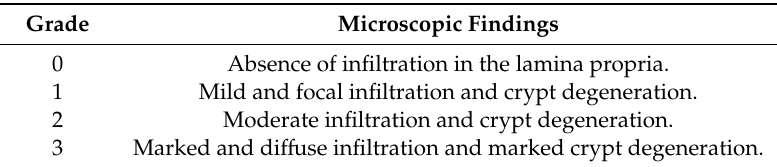
Table 1. Histopathological criteria of colitis grades. Grade Microscopic Findings 0 Absence of infiltration in the lamina propria. 1 Mild and focal infiltration and crypt degeneration. 2 Moderate infiltration and crypt degeneration. 3 Marked and di ff use infiltration and marked crypt